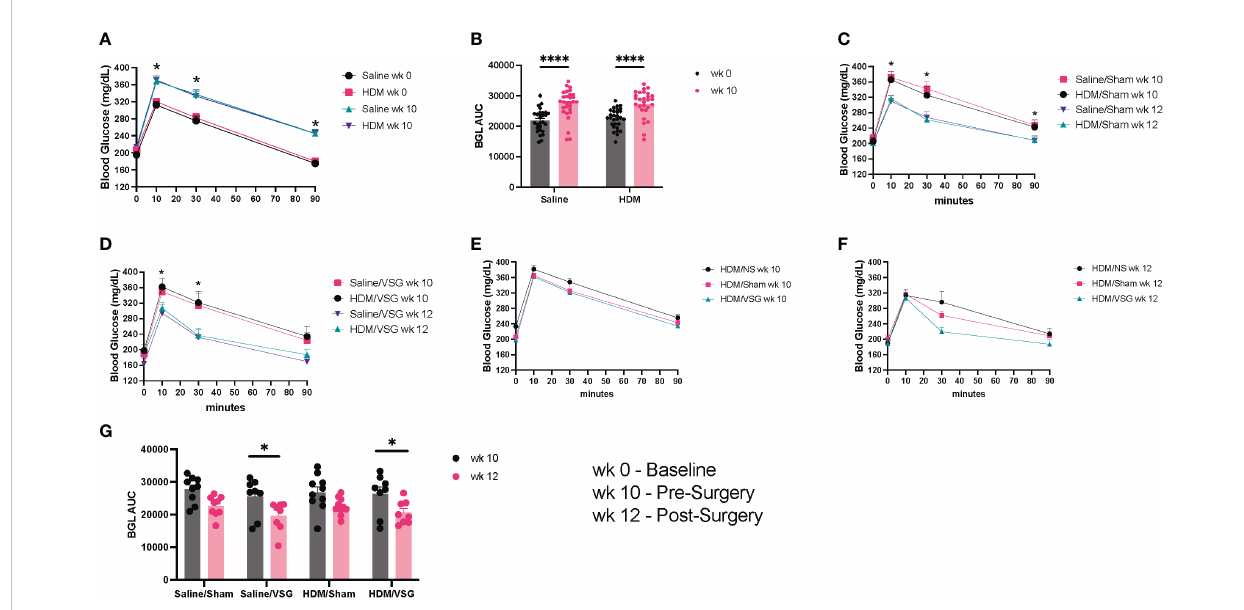
FIGURE 3 Glucose tolerance. (A) Glucose tolerance curves at week (wk) 0 and wk 10, n= 28-29 mice per group. (B) Blood glucose area under the curve (AUC) at wk 0 and wk 10. (C, D) Glucose tolerance curves at wk 10 and wk 12 for (C) Sham (*p<0.05 for HDM/Sham wk 10 vs wk 12 and PBS/Sham wk 10 vs wk 12) and (D) VSG mice (*p<0.05 for HDM/VSG wk 10 vs wk 12), n=8-10 mice per group. (E) Glucose tolerance curves at wk 10 for HDM- challenged mice. (F) Glucose tolerance curves at wk 12 for HDM-challenged mice. (G) Blood glucose AUC at wk 10 and wk 12 for Sham and VSG mice. (A, C – F) were analyzed using paired t-test and One-way ANOVA and (B, G) were analyzed using a Two-way ANOVA with a Tukey and Sidak post-hoc test. *p<0.05, ****p<0.0001.